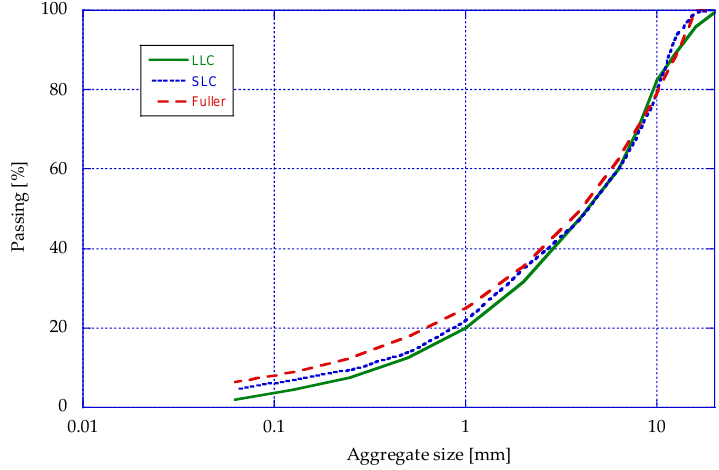
Figure 1. Grading distribution of the designed mixes.